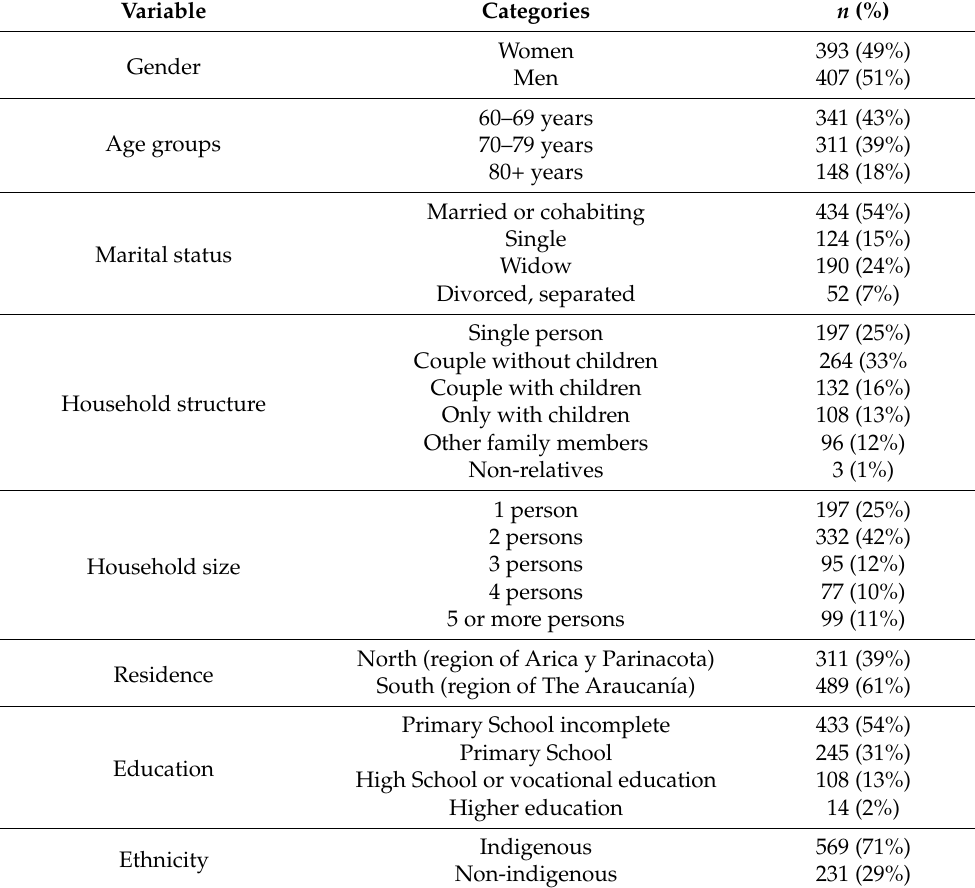
Table 1. Participants’